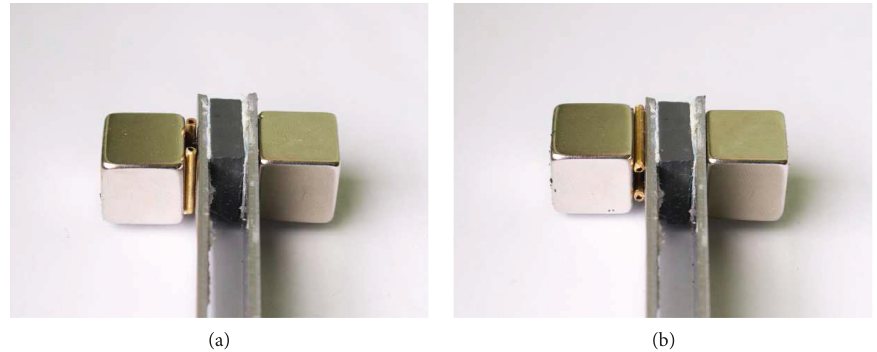
Figure 16: The rolls placed in two directions to analyze the effect of alignment of the